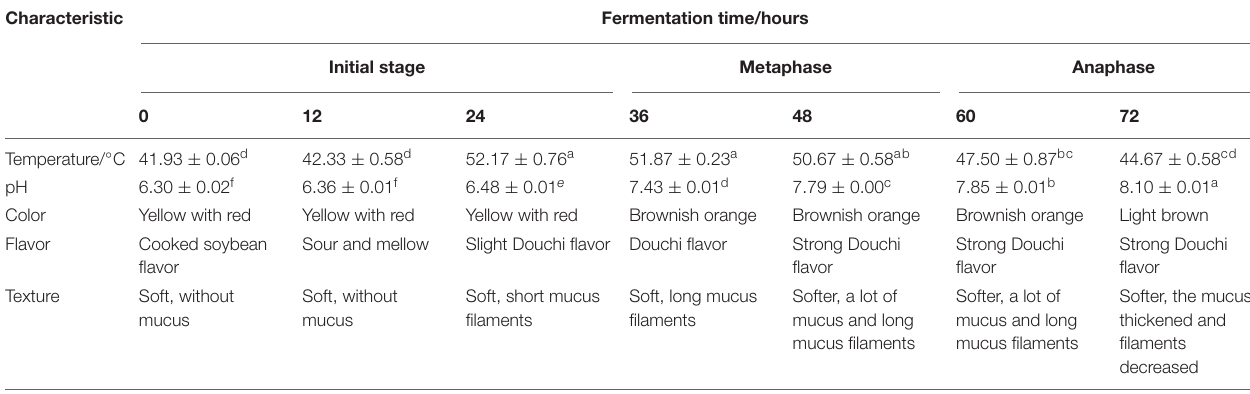
TABLE 1 | Changes in the pH value, temperature, and sensory characteristics of the non-post fermented Shuidouchi during fermentation. Characteristic